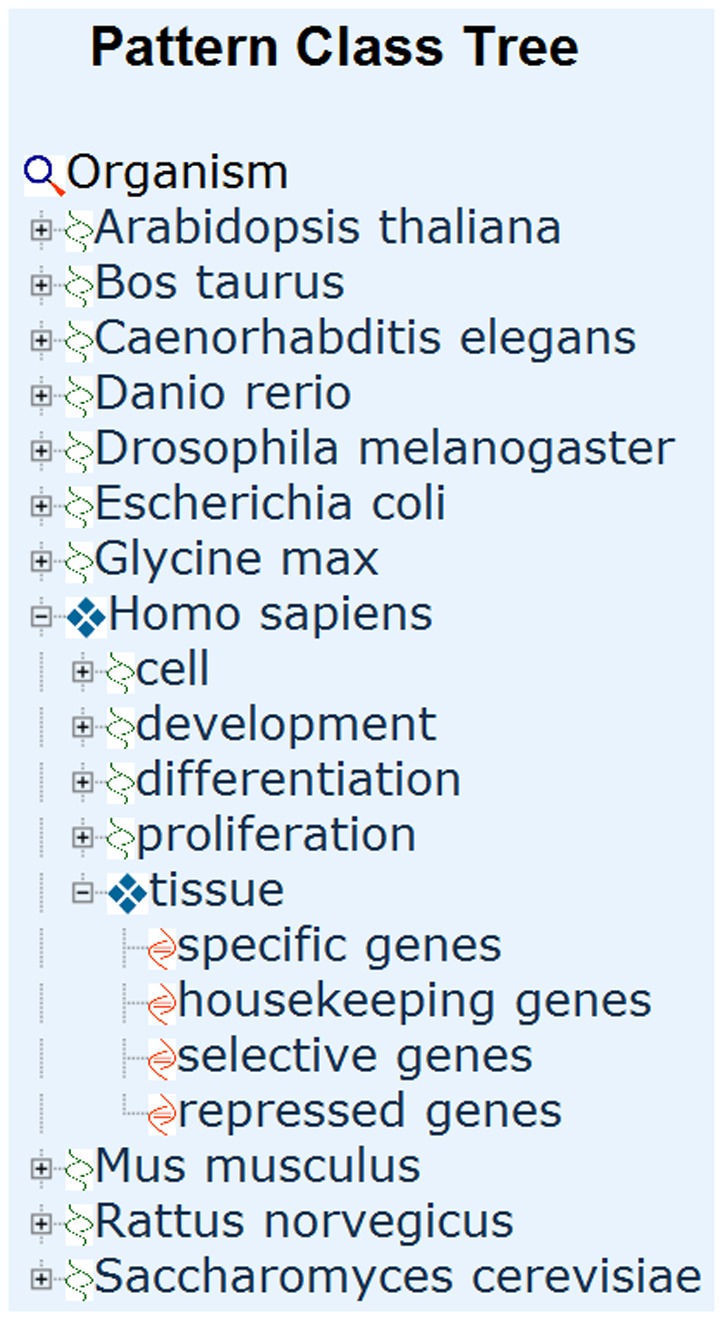
The Browse Method.